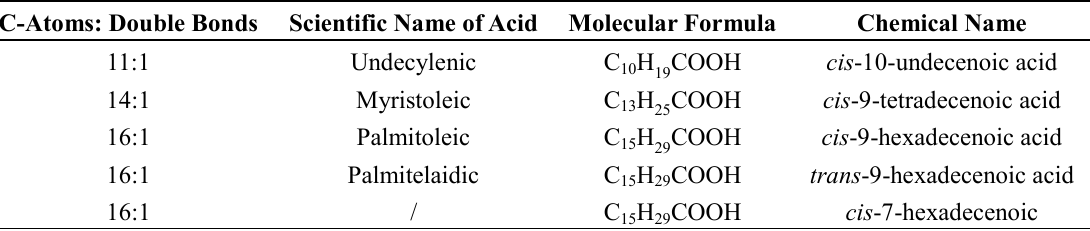
Table 1. Selected monounsaturated fatty